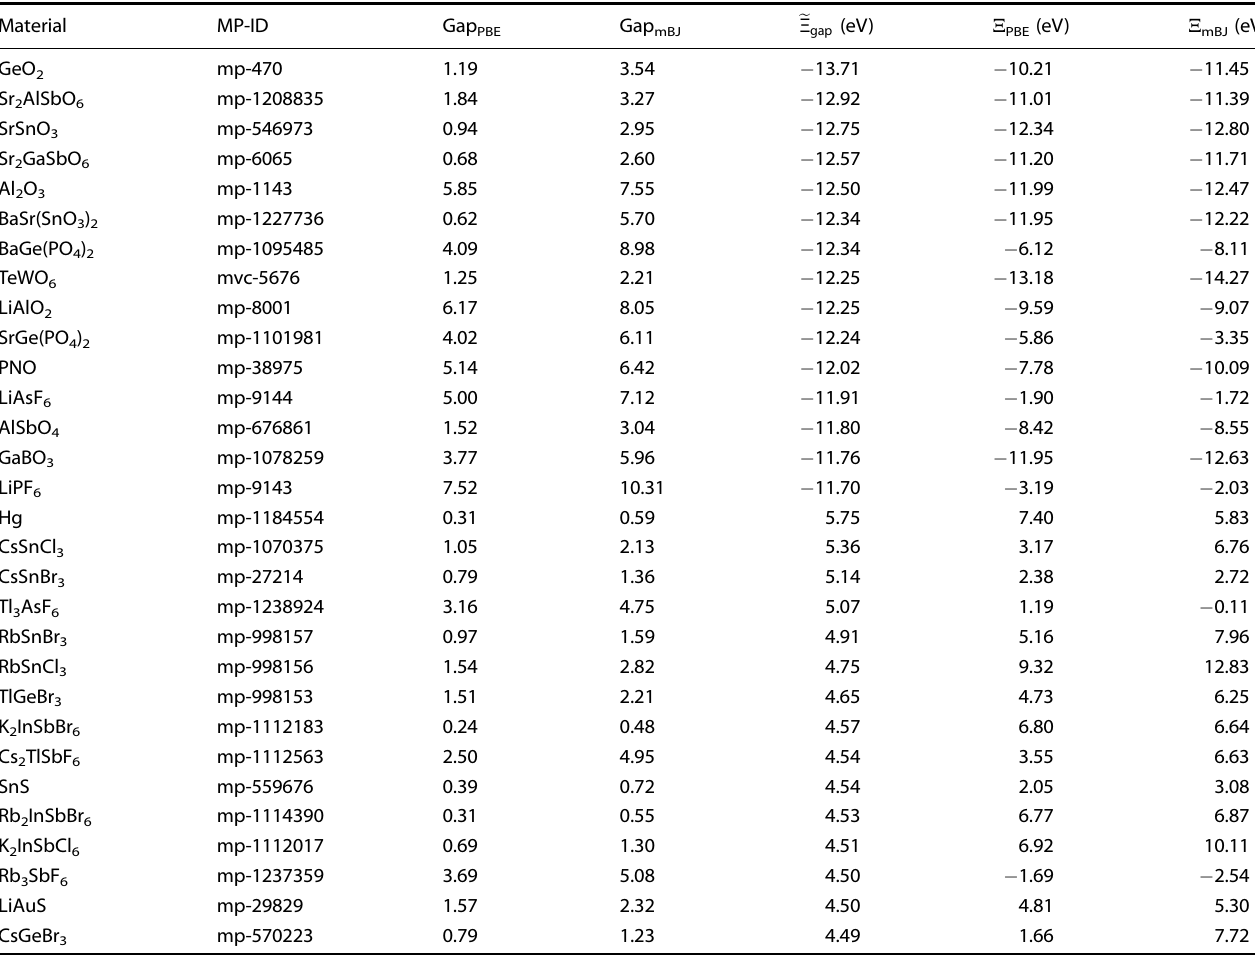
Table 5. Full deformation potential for speci fi c